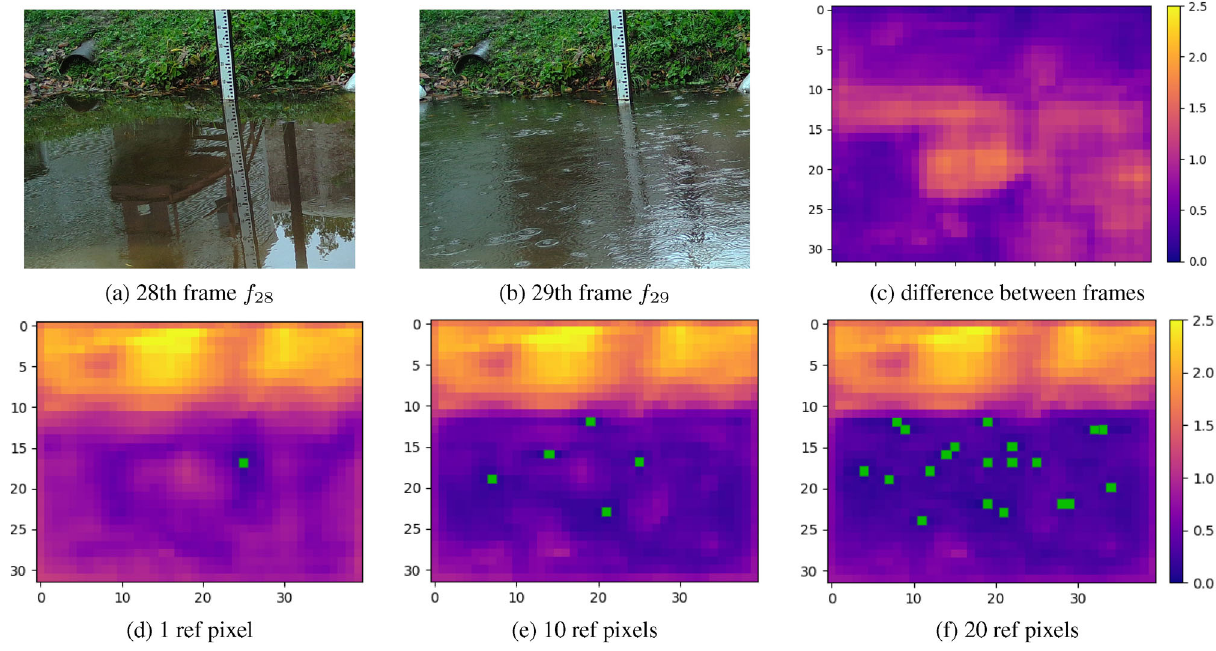
Fig. 1 Appearance differences between frames. (a, b) Two consecutive frames, f 28 and f 29 , of a video from which we wish to segment the water region. Using our feature encoder trained on WaterDataset , the feature maps of f 28 and f 29 are very different; their l 2 -norm distance are visualized in (c). If a pixel in f 29 , the green pixel in (d), is picked as a reference, features extracted from other water regions in f 29 share better similarity with this reference. (d) color-encodes the l 2 -norm distance between the green pixel’s feature vector and features of other regions. (e) The l 2 -norm distance when 5 reference pixels are selected. (f) The l 2 -norm distance when 20 reference pixels are selected. Green pixel regions are selected as references. When appearance changes dramatically, the spatial correlations of features may be stronger than their temporal